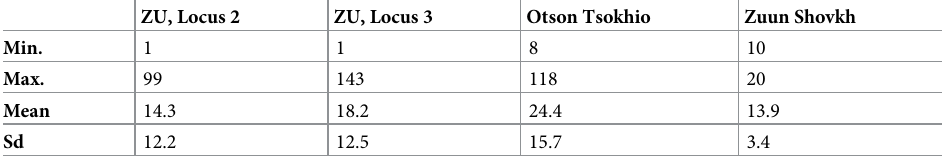
Table 4. Summary of bone fragment measurements (mm), as recorded in S2 Table.